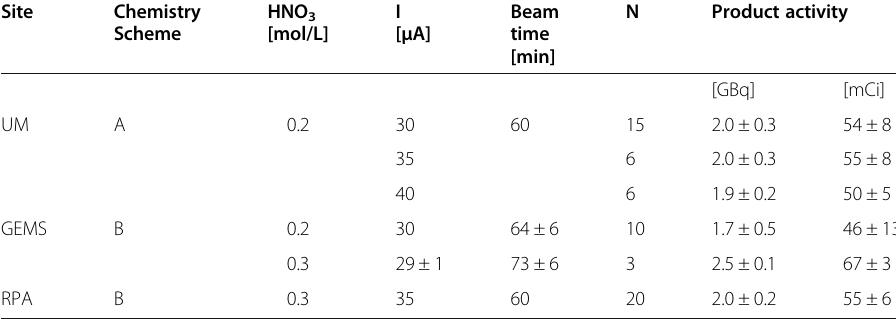
Table 5 Overview of [ 68 Ga]GaCl 3 productions (EOS) Site Chemistry Scheme